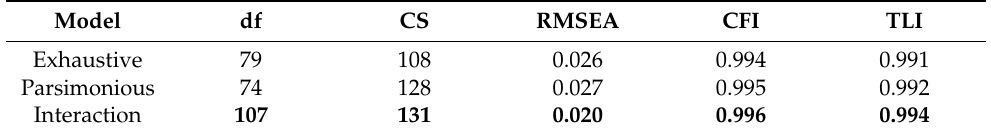
Table 5. Fit of final SEM